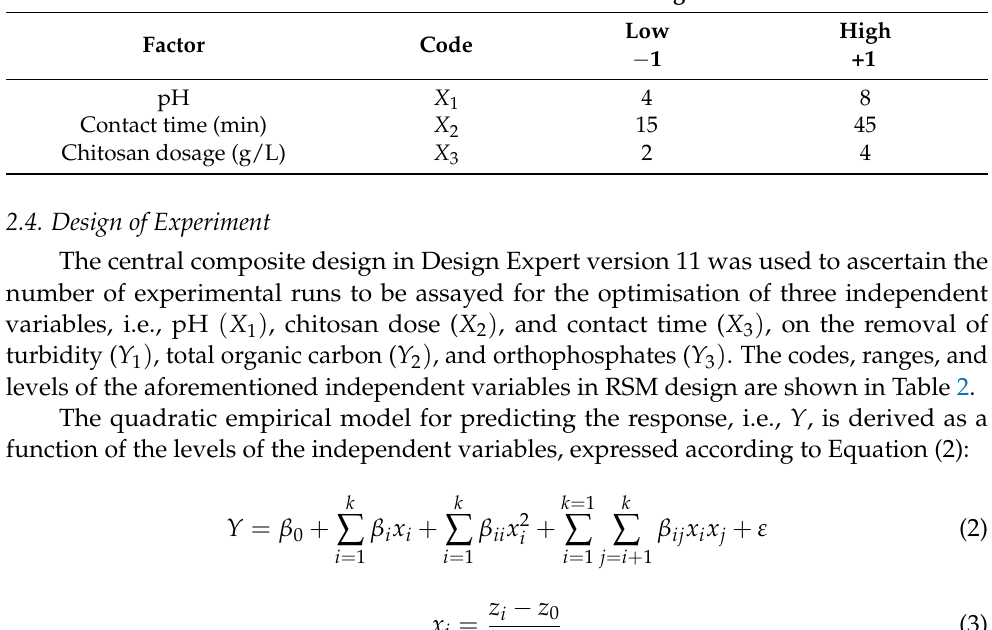
Table 2. Codes, ranges, and levels of independent variables of composite design in RSM. Factor Code pH X 1 4 8 Contact time (min) X 2 15 45 Chitosan dosage (g/L) X 3 2